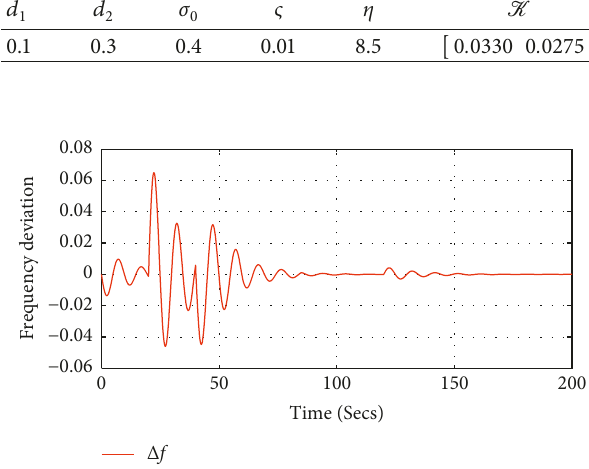
Figure 5: Evaluation of △ f in equation (38) in Theorem